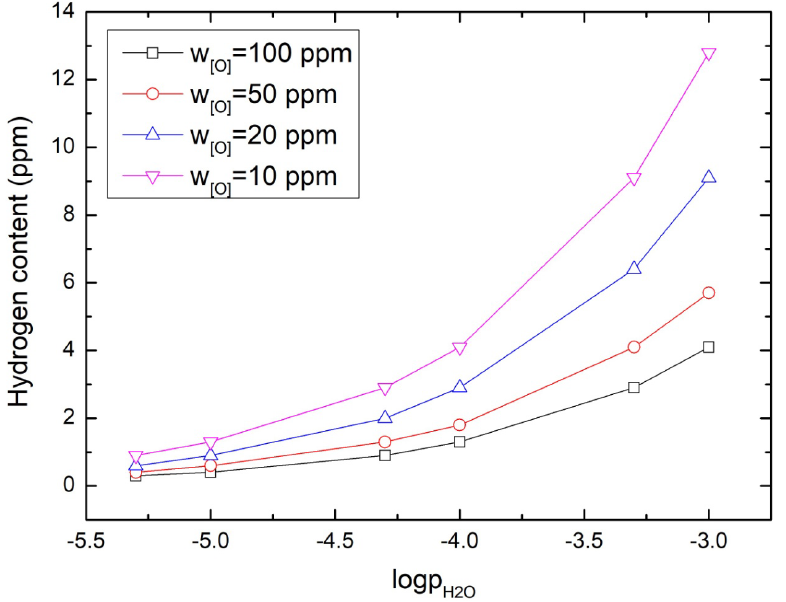
Figure 6. The effect of partial pressure of steam on hydrogen content in steel at 1873 K.